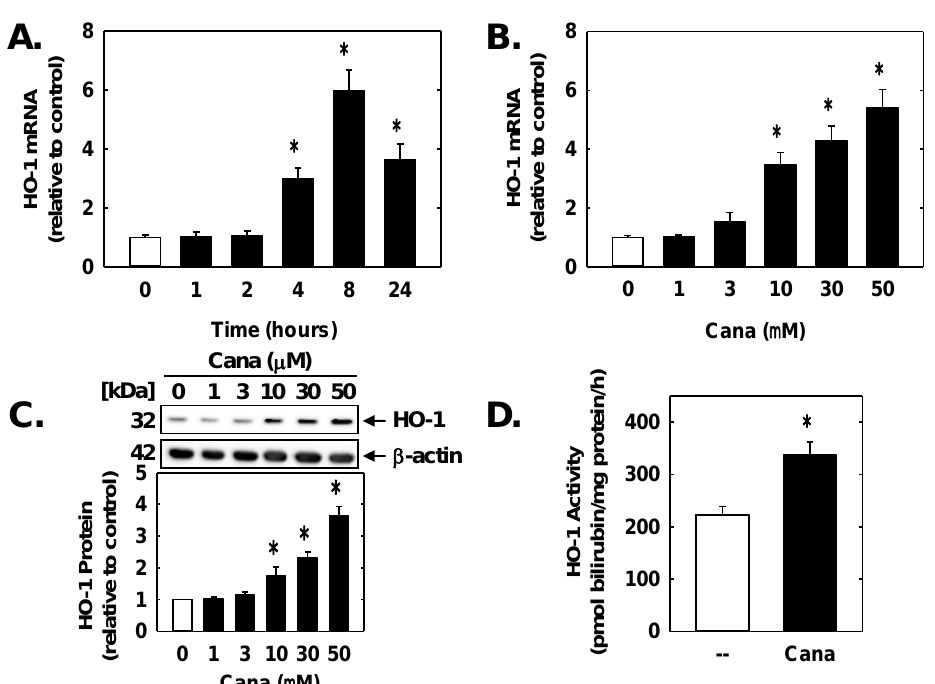
Figure 1. Canagliflozin (Cana) stimulates HO-1 expression in human ECs. ( A ) Cana (50 µM) stimu- lates a time-dependent increase in HO-1 mRNA expression. ( B ) Effect of Cana (0 – 50 µM) exposure for 8 h on HO-1 mRNA expression. ( C ) Effect of Cana (0 – 50 µM) exposure for 24 h on HO-1 protein expression. ( D ) Effect of Cana (50 µM) exposure for 24 h on HO activity. Results are mean ± SEM ( n = 4–6). * Statistically significant effect of Cana.